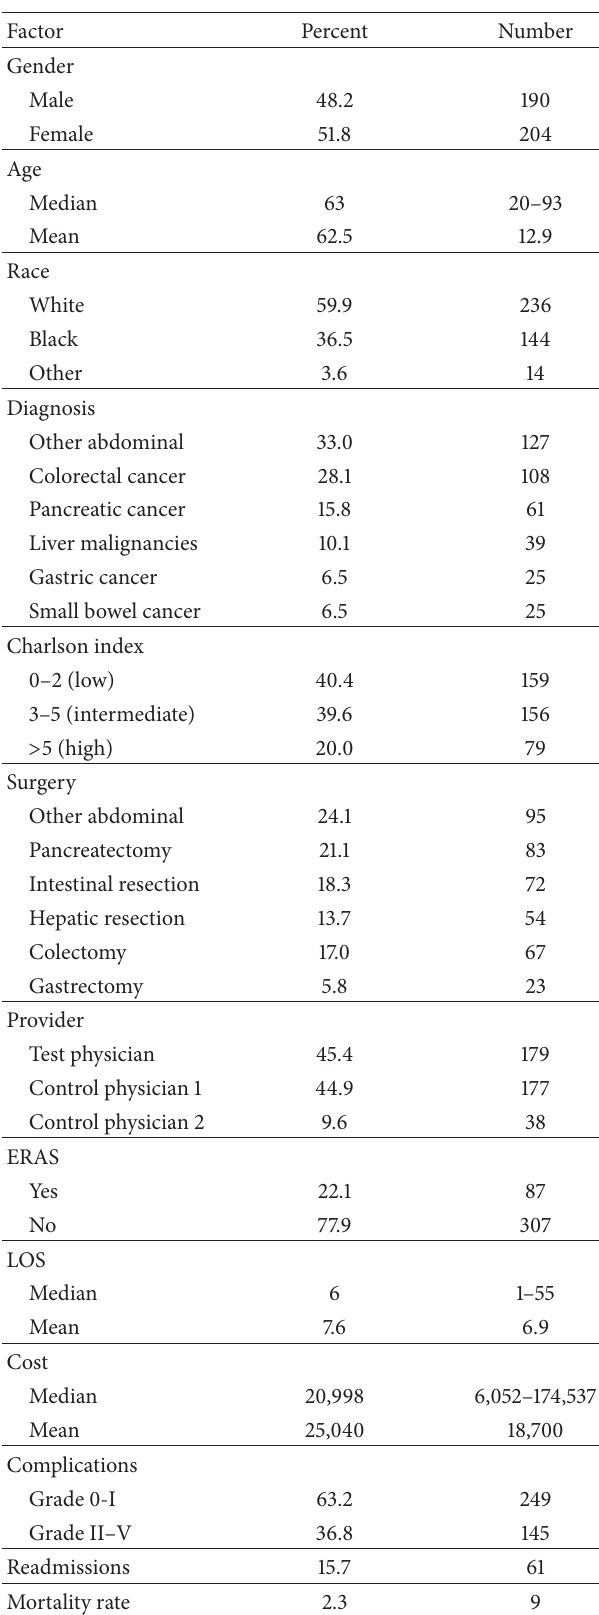
Table 2: Demographics for all patients on a single surgical